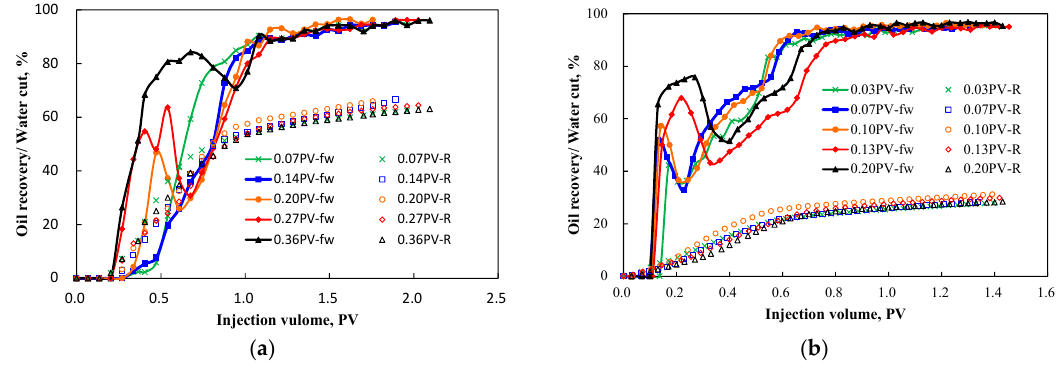
Figure 4. Macroscopic oil displacement results for ( a ) homogenous cores and ( b ) layered heterogeneous cores. ( f w —water cut, R —oil recovery).